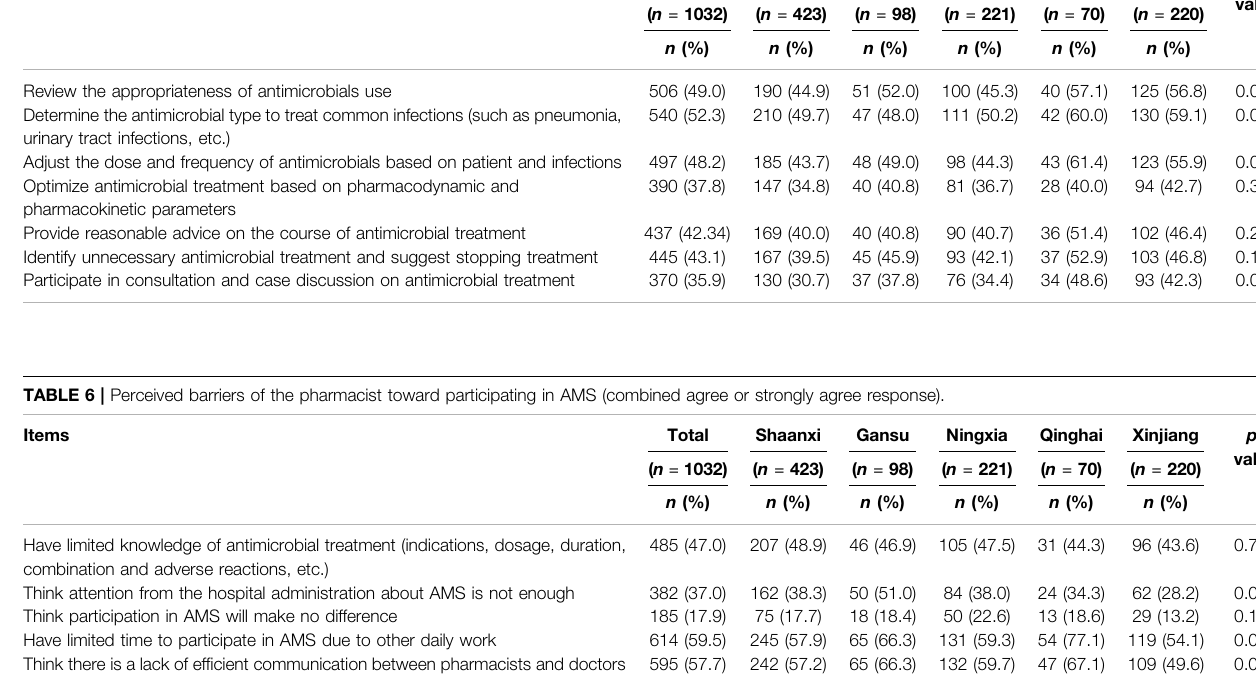
TABLE 5 | Pharmacist ’ s con fi dence in performing AMS activities (with con fi dent or strongly con fi dent response). Items